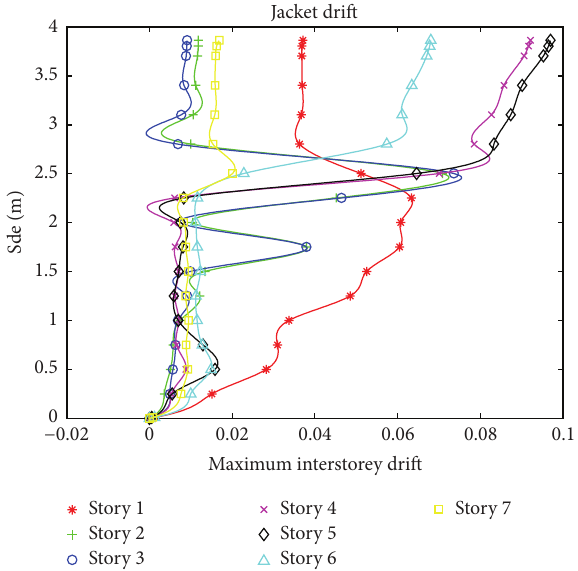
Figure 15: IDA curves of different storeys of jacket part subjected to record number 17.